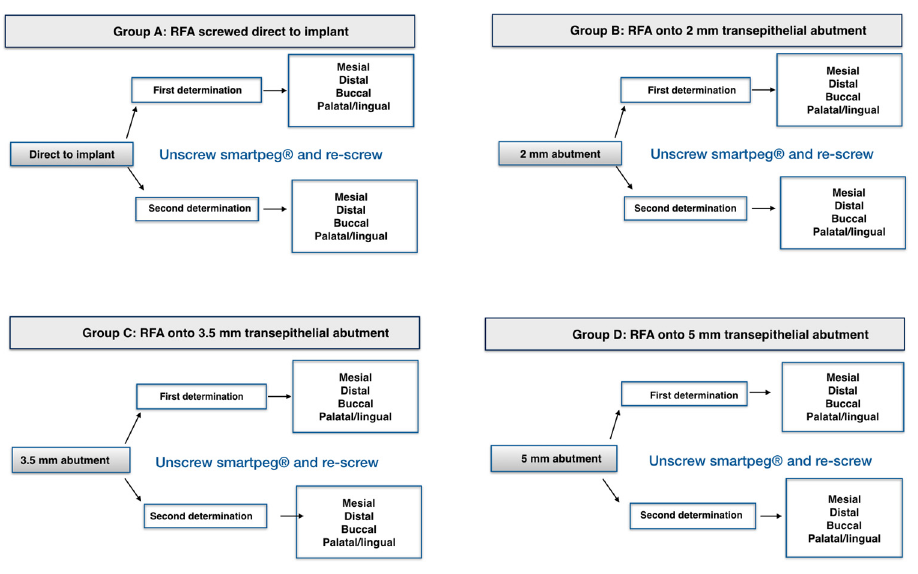
Figure 1. Resonance frequency analysis (RFA) registration protocol.